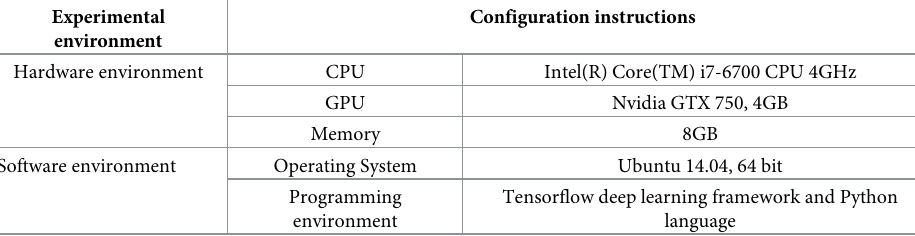
Table 3. Hardware and software environment configurations.